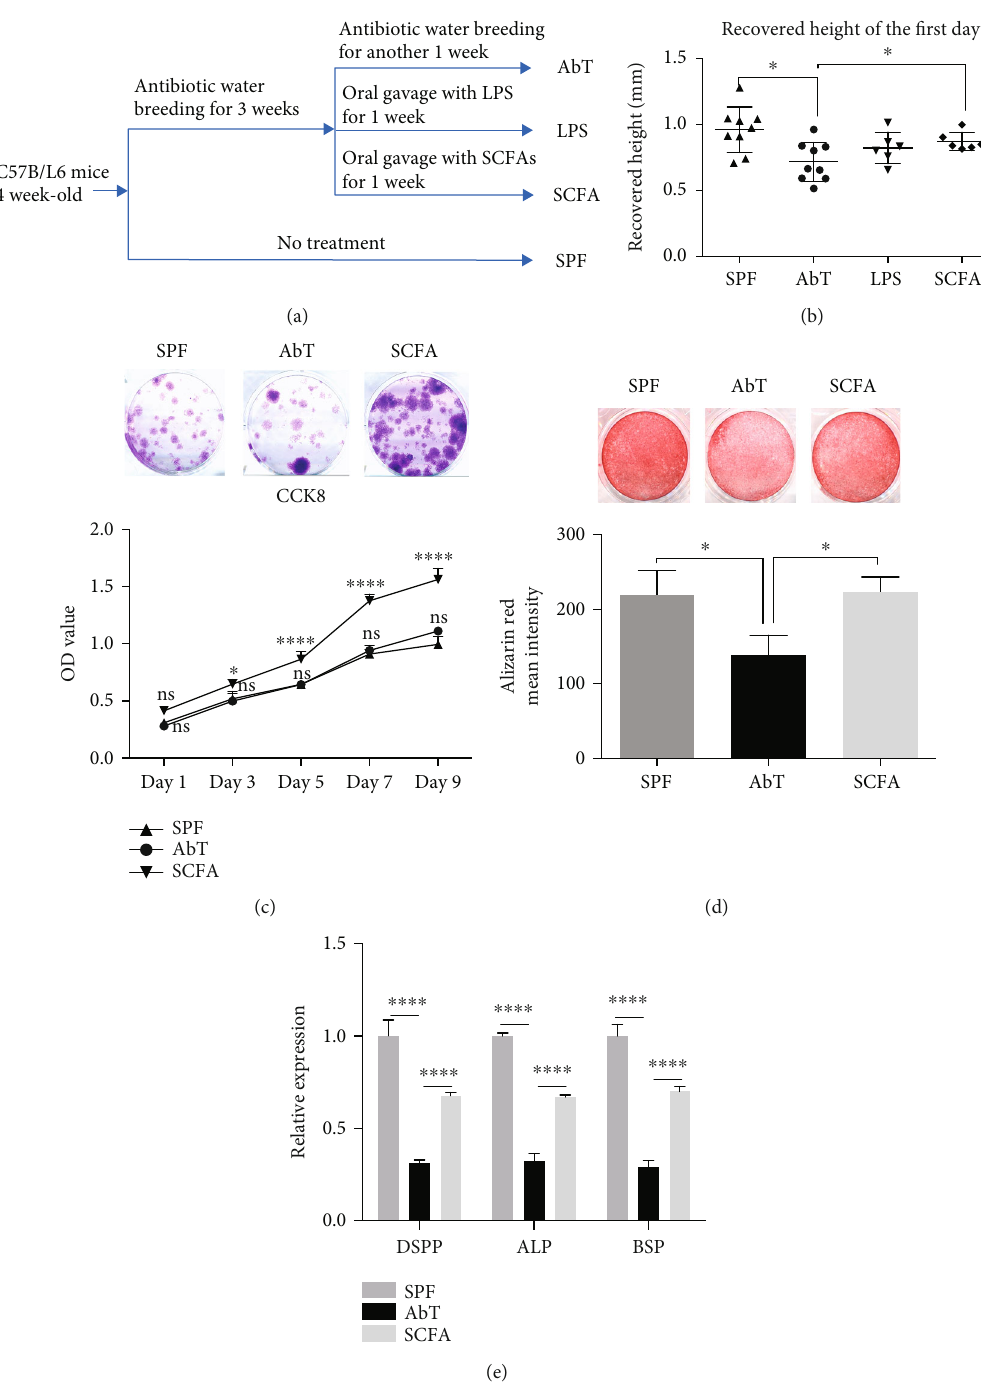
Figure 4: SCFAs but not LPS could rescue the mouse incisor growth rate and reinforced characteristics of DPSCs after antibiotic treatment. (a) Experimental procedure schematic. (b) The result of recovered height of injured incisors at the fi rst day showed signi fi cant reduction in AbT compared to SPF and SCFA gavage, while LPS gavage showed no di ff erence when compared with AbT. (c) DPSCs derived from SCFA mice showed greater colony-forming and proliferative capacity in vitro . (d) Alizarin red staining showed that SCFA-DPSCs formed more mineralized nodule than AbT DPSCs, and there was no signi fi cant di ff erence between SCFA and SPF. (e) Real-time PCR results showed that the expression of DSPP , ALP , and BSP was higher in SCFA compared to that of AbT, while SPF showed the highest expression of mRNA above. All experimental data were veri fi ed in at least three independent experiments. Error bars represent the SEM from the mean values. ∗∗∗∗ P < 0 : 00001 ; ∗∗ P < 0 : 01 ; ∗ P < 0 : 05 . AbT: antibiotic treated; ConvD: conventionalized; SPF: speci fi c pathogen-free; DSPP: dentin sialophosphoprotein; ALP: alkaline phosphatase; BSP: bone